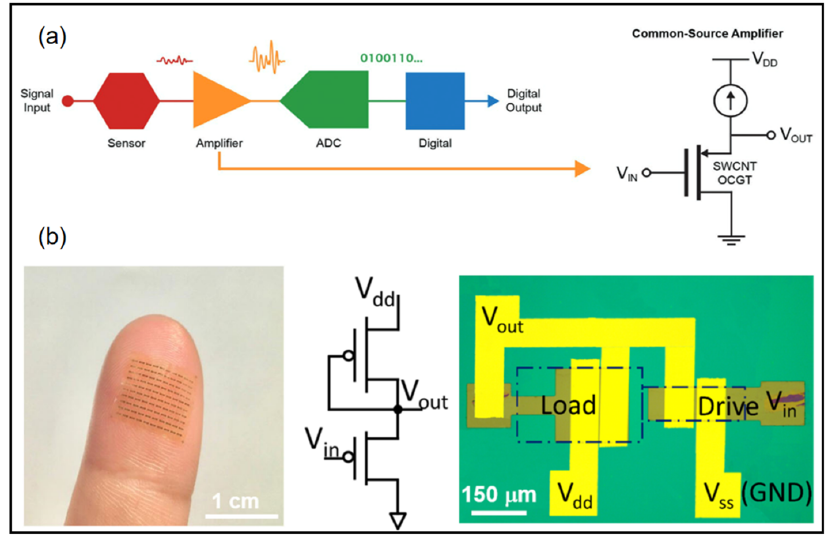
Figure 9. ( a ) Overview of common signal acquisition systems [93] ( b ) Flexible device array lami